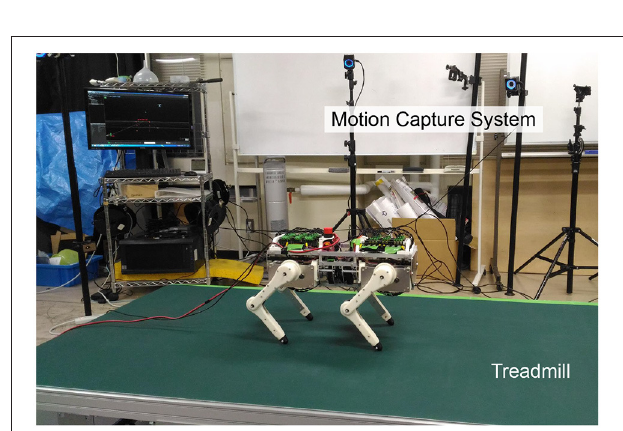
FIGURE 7 | Snapshot of the experimental